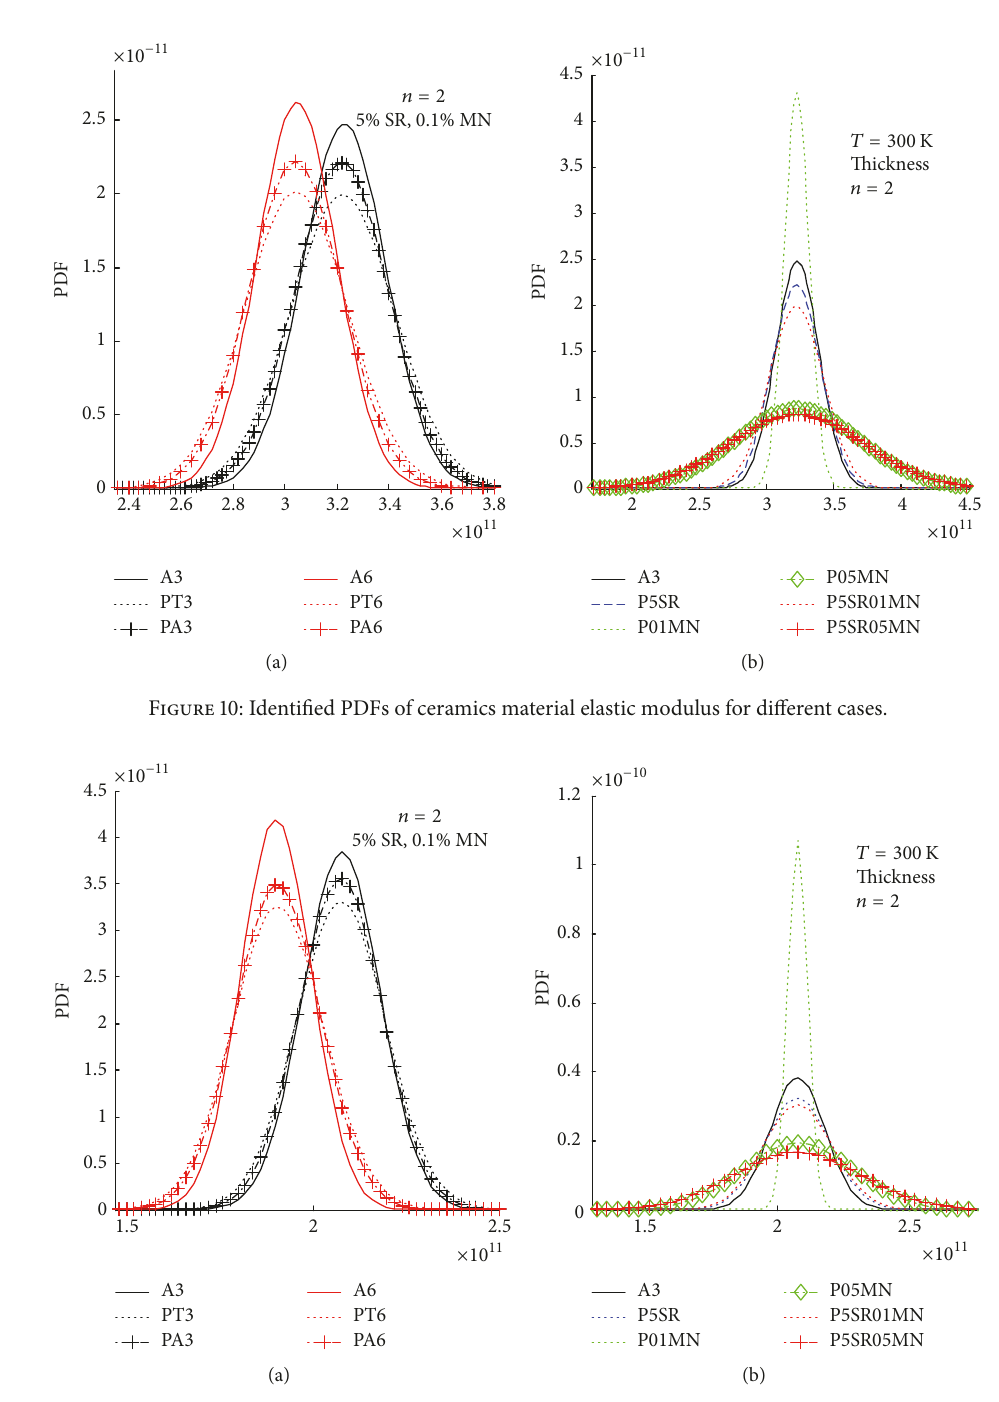
Figure 11: Identified PDFs of metal material elastic modulus for different